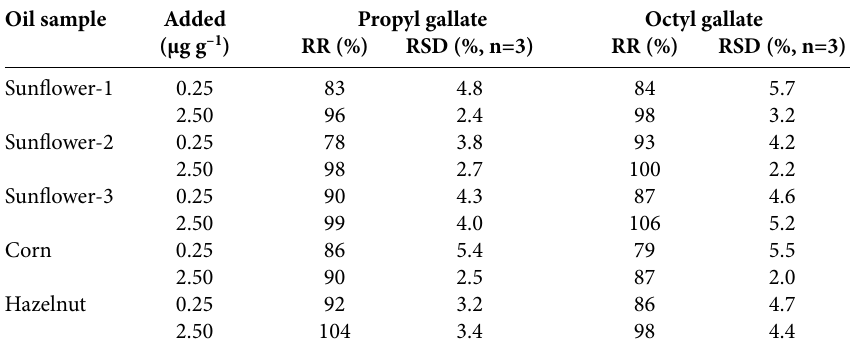
Table 3. Spiked recoveries (accuracies of determination) of alkyl gallates in vegetable oil samples. Oil sample